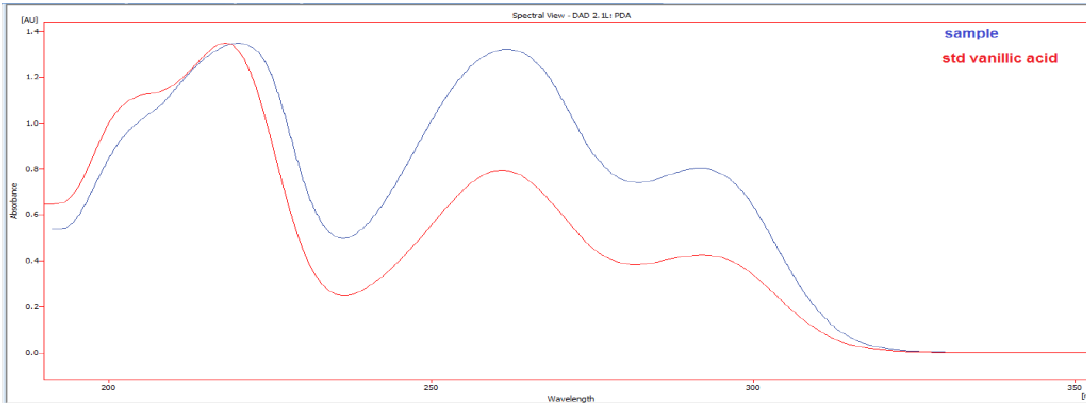
Figure 5. UV spectrum of standard vanillic acid and isolated cpdE1.